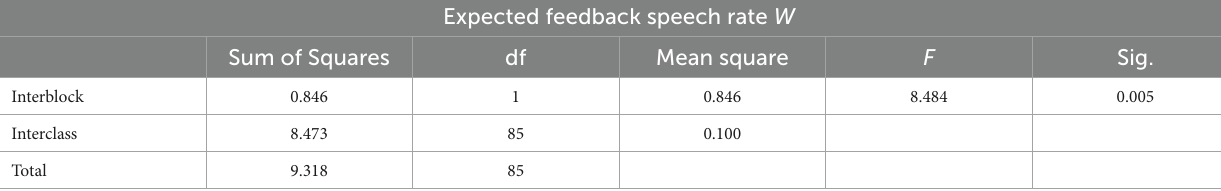
TABLE 10 One-way ANOVA test for expected feedback speech rate in different word counts of dialog